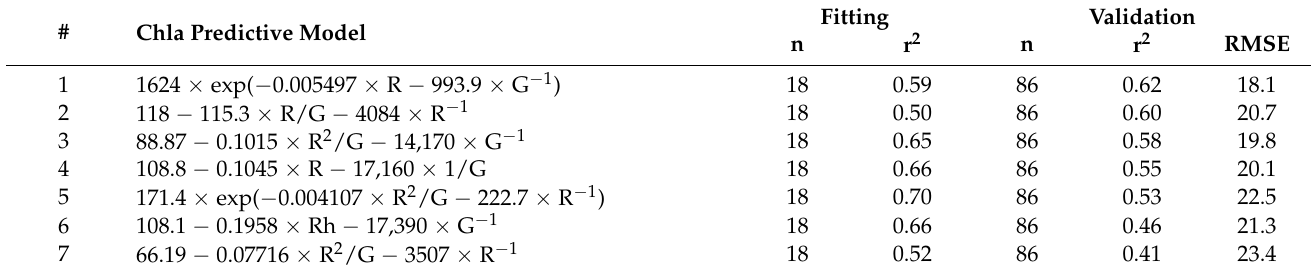
Table 4. Regression models for chlorophyll- a (chla) estimation, in µ g/L, that matched the minimum criteria for selection, namely r 2 ≥ 0.5 for fitting and r 2 ≥ 0.4 for validation. The models were fitted with field reflectance and chla data from Dataset 2 and validated with chla from the other datasets and with the surface reflectance from MODIS products MOD09GA and MYD09GA.